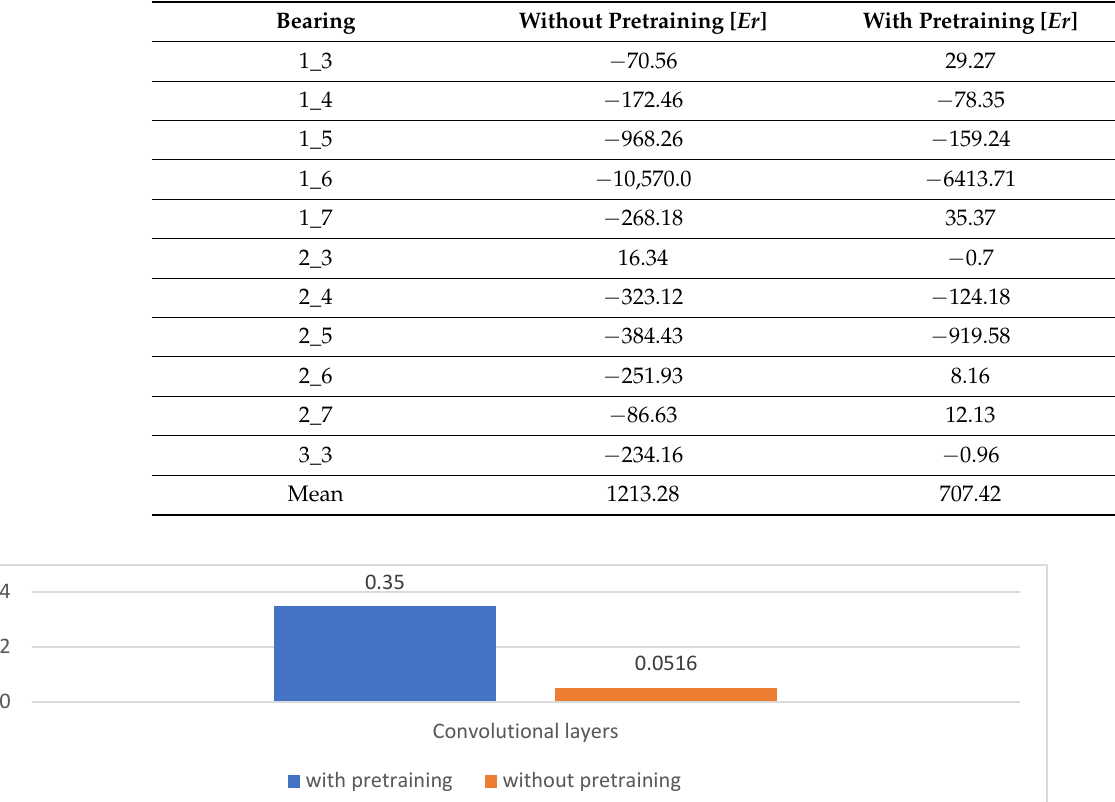
Table 2. Detailed results of the proposed RUL framework with and without transfer learning. For each of the 11 bearings, the relative error Er according to Equation (1) is shown. In addition, the mean of all values is given.